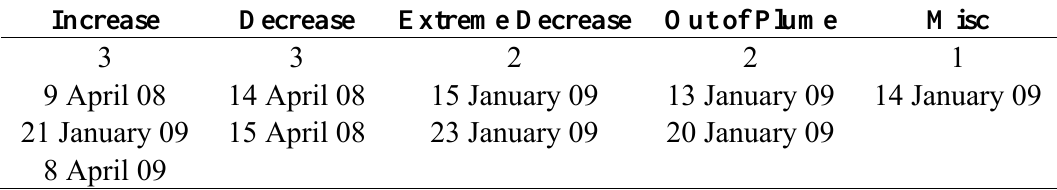
Table 4. Fort Benning burns listed by plume characteristics.